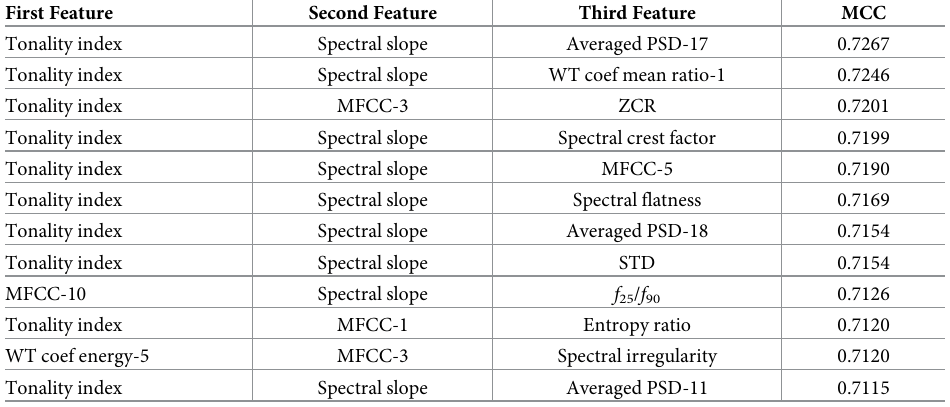
Table 12. MCC of the best three features vectors for wheeze and normal sound classification using logistic regres- sion on the Test-Set.